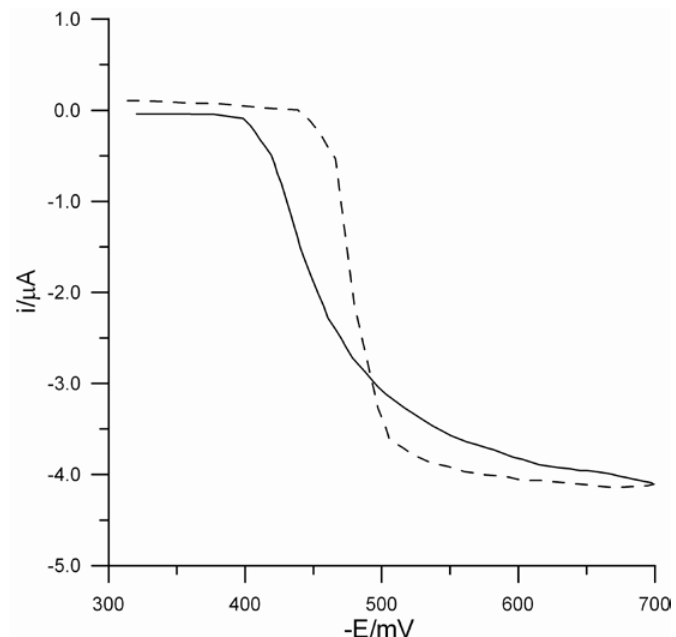
Figure 3. The DC polarograms of 1×10 -3 mol dm -3 In(III) in 1 mol dm -3 NaClO (dotted line)